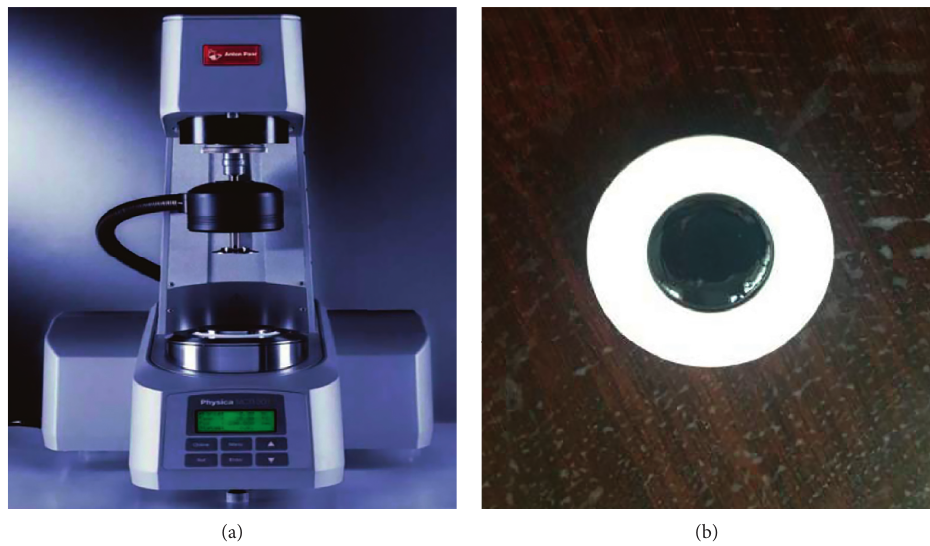
Figure 2: DSR test. (a) Physica MCR 301(Anton Paar). (b) Test sample.